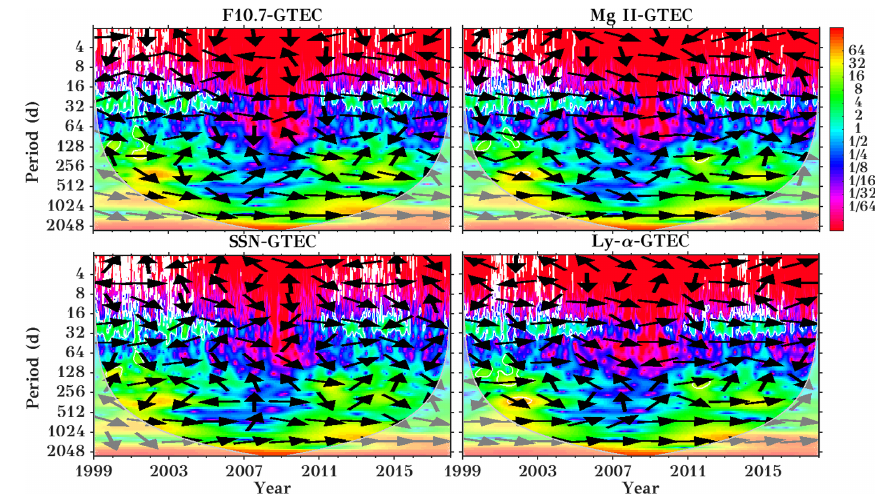
Figure 3. Cross-wavelet spectra for GTEC and different solar proxies during the years 1999 to 2017. The thin gray line shows the cone of influence, where a white line surrounds significant values. The arrows indicate the phase relationship, with in-phase and anti-phase relation shown by arrows pointing to the right and left, respectively, while a downward or upward direction means that GTEC is leading or lagging, respectively. x axis labels refer to 1 January of the respective year.